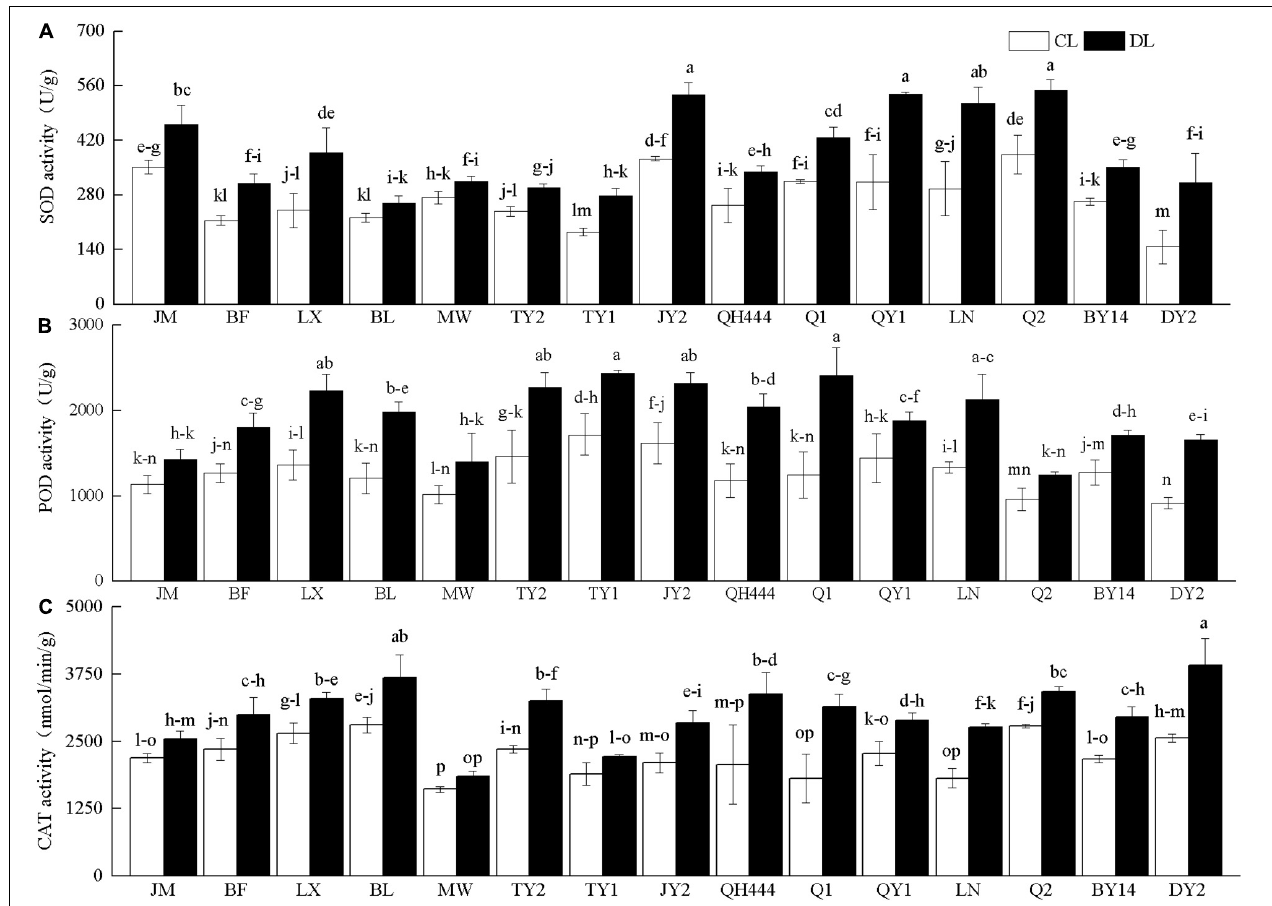
FIGURE 3 | Superoxide dismutase (SOD) (A) , peroxidase (POD) activity (B) , and catalase (CAT) activity (C) in oat varieties under drought stress. Each value represents the mean ± standard deviation. Each experiment was repeated three times. An analysis of variance test was performed, followed by Tukey test. CL, untreated control; DL, drought stress. Different letters indicate that the differences between treatments were significant ( P <